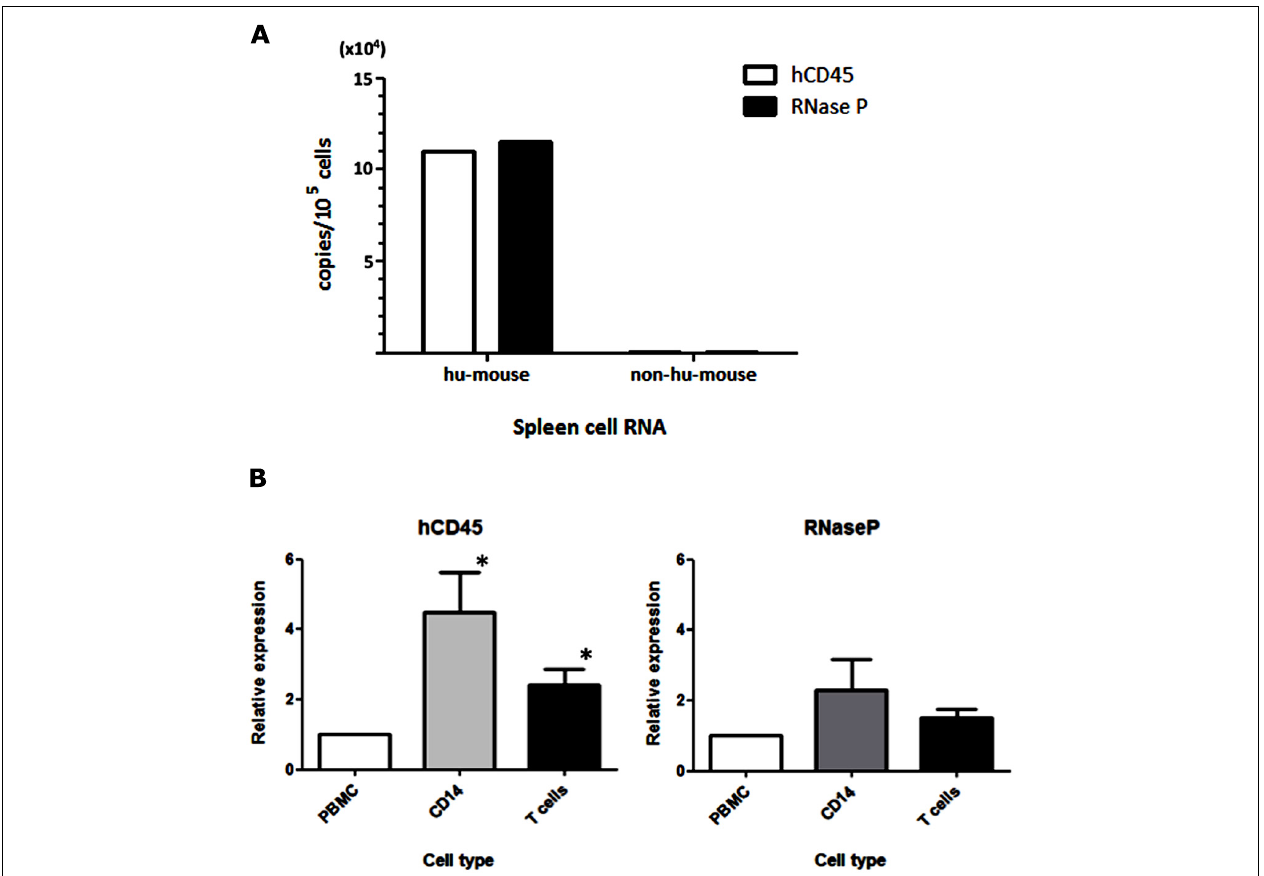
fractionated into CD14 + monocytes and T cells. RNA from these cell populations was extracted, and the expression levels of hCD45 and RNase P were analyzed by qRT-PCR. The graph depicts the expression levels in these fractionated cells relative to the levels in PBMCs (defined as 1). Statistical differences in hCD45 and RNase P expression among these cell populations were evaluated by non-parametric one-way ANOVA test (* P <